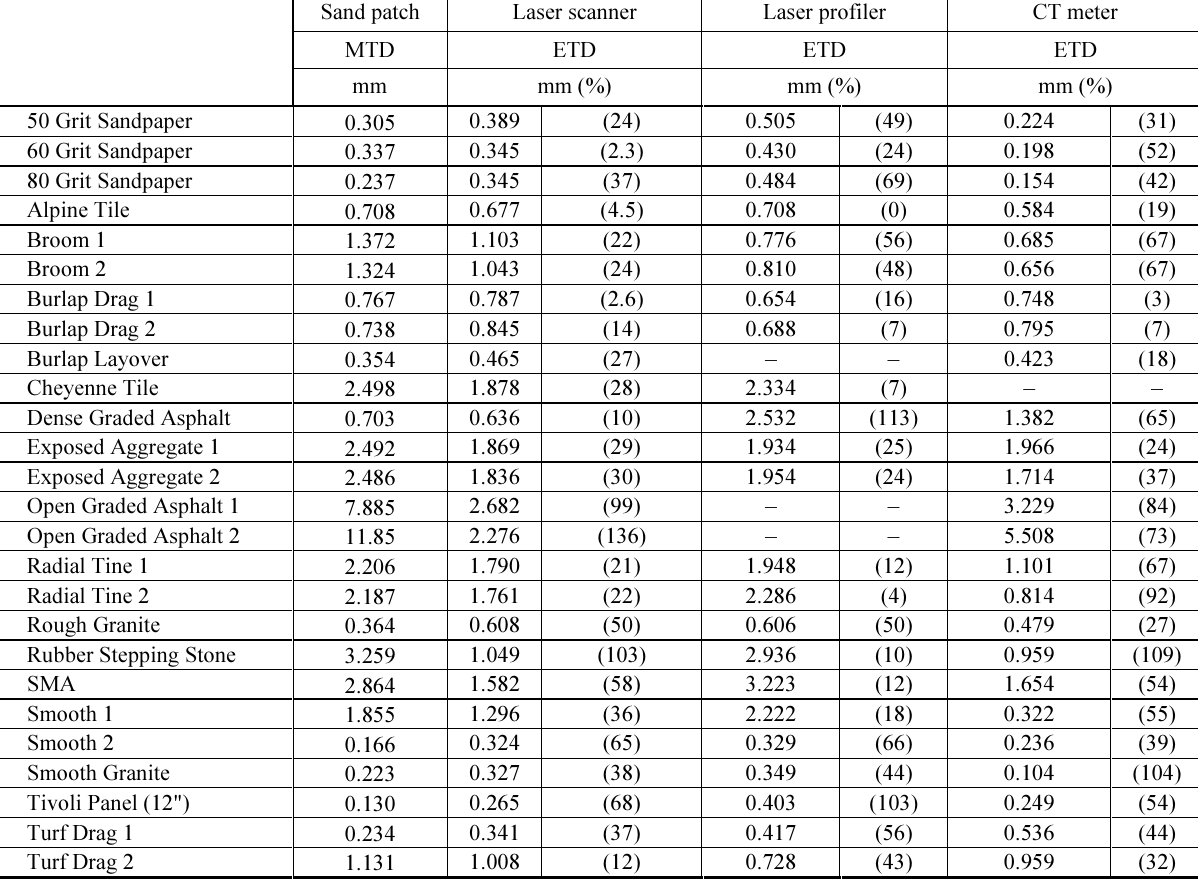
Table 1. Average MTD from sand patch tests compared with average ETD and percent difference for Ames laser texture